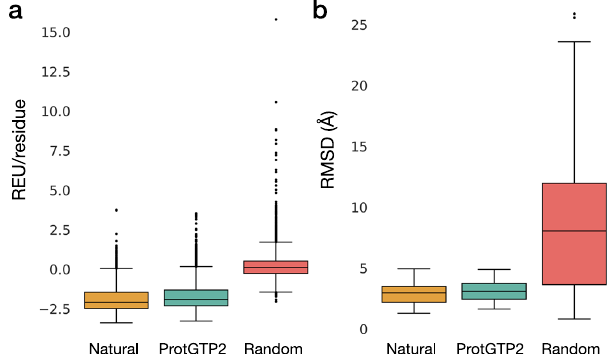
Fig.3|ComparisonofRosettaandmoleculardynamicscalculationsamongthe three datasets. a Average Rosetta energy units per residue for the three datasets. AlphaFold prediction structures were used as input for the Rosetta RelaxBB pro- tocol.10,000structureswererunperdataset,onereplicapersystem. b Rootmean square deviation (RMSD) distribution for each MD dataset as computed by aver- aging RMSDs independently for each trajectory, represented as a boxplot. Twelve structures were simulatedper dataset, three replicas per system.Inboth plots, the median is indicated as a black line; boxes depict the interquartile range (IQR), and whiskers represent 1.5 x IQR. Points outside this range are displayed as individual data